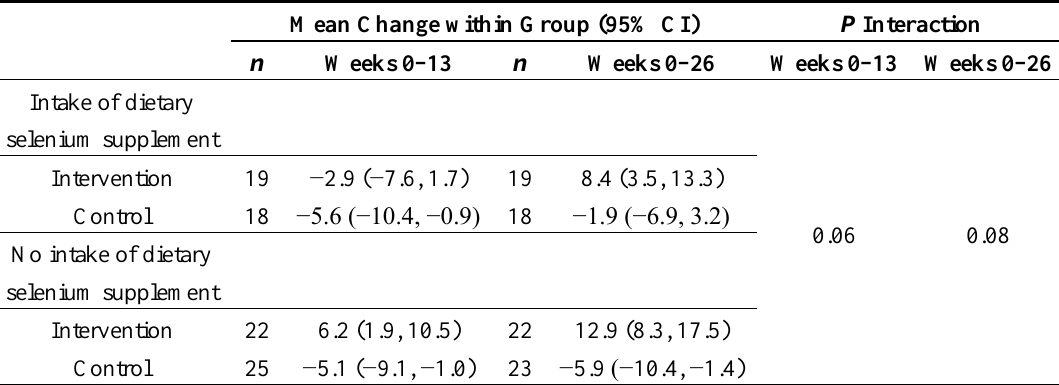
Figure 2. Whole blood selenium concentrations for the intervention and the control group presented as 5th, 25th, 50th, 75th and 95th percentiles for Weeks 0, 13, and 26. Table 3. Change within group in whole blood selenium concentrations, stratified by intake of dietary selenium supplement between 3 and 12 months before study